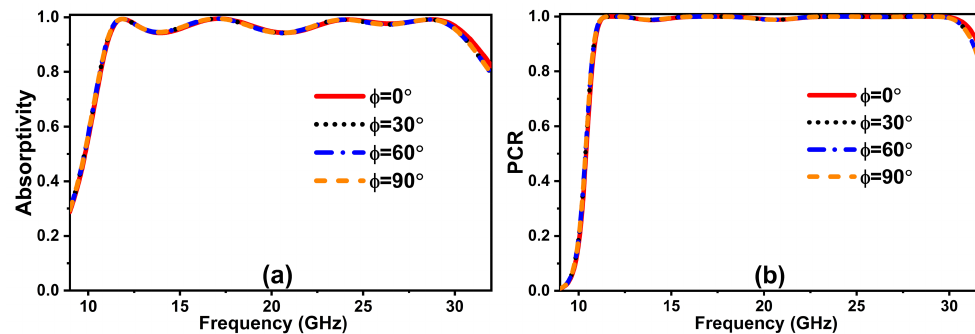
Figure 9. ( a ) Absorptivity and ( b ) PCR responses at different polarization angles.